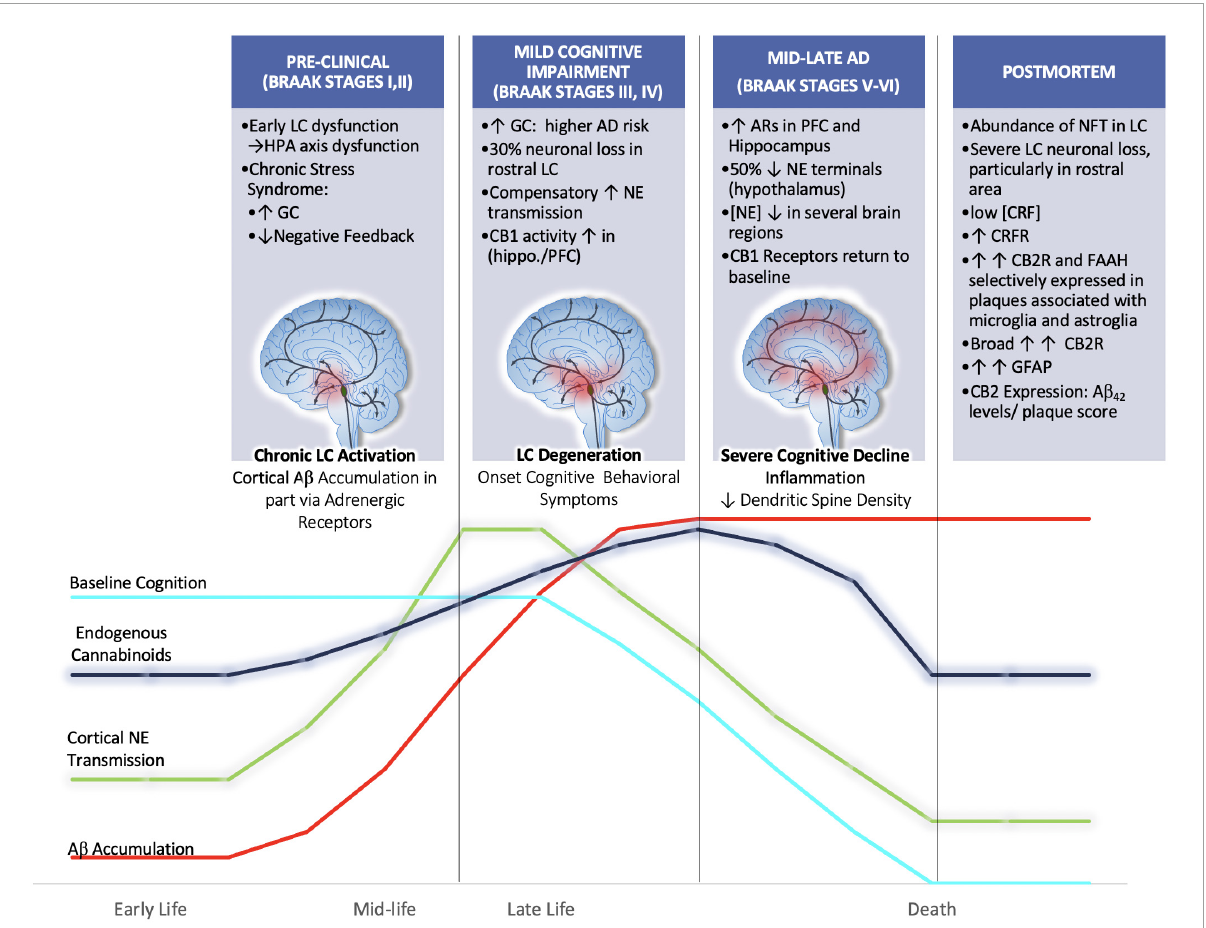
FIGURE5 We hypothesize that aberrant activation of LC neurons during chronic stress in mid-late stages of life may render the brain more vulnerable to A β accumulation and senile plaque deposition. Further we hypothesize that endogenous cannabinoid compensation occurs in response to LC-NE system dysregulation preceding and after the onset of LC neurodegeneration. Clinical postmortem data show that between the prodromal (preclinical; Braak Stages I,II) and mild cognitive impairment (Braak stages III-IV) there is a 30% decrease in rostral LC volume (Theofilas et al., 2017). Remaining LC neurons compensate for neuronal loss by increasing NE production and transmission (Szot et al., 2006). Human AD brains in Braak Stages III, IV show increased CB1 activity in hippocampal and inner frontal cortical layers (Manuel et al., 2014). By the time disease progression reaches Braak stages V, VI there is human postmortem evidence for the upregulation of ARs in the PFC and hippocampus, thus suggesting that LC degeneration is causing decreases in NE transmission at this point (Kalaria et al., 1989). The loss of NE tone is supported by studies that have reported decreased concentrations of NE in the hypothalamus, cingulate, putamen and raphe nuclei (Mann et al., 1980; Arai et al., 1984). Further, during Braak stages V, VI, it has been shown that CB1r levels are decreased from their elevated state, returning to baseline levels (Manuel et al.,